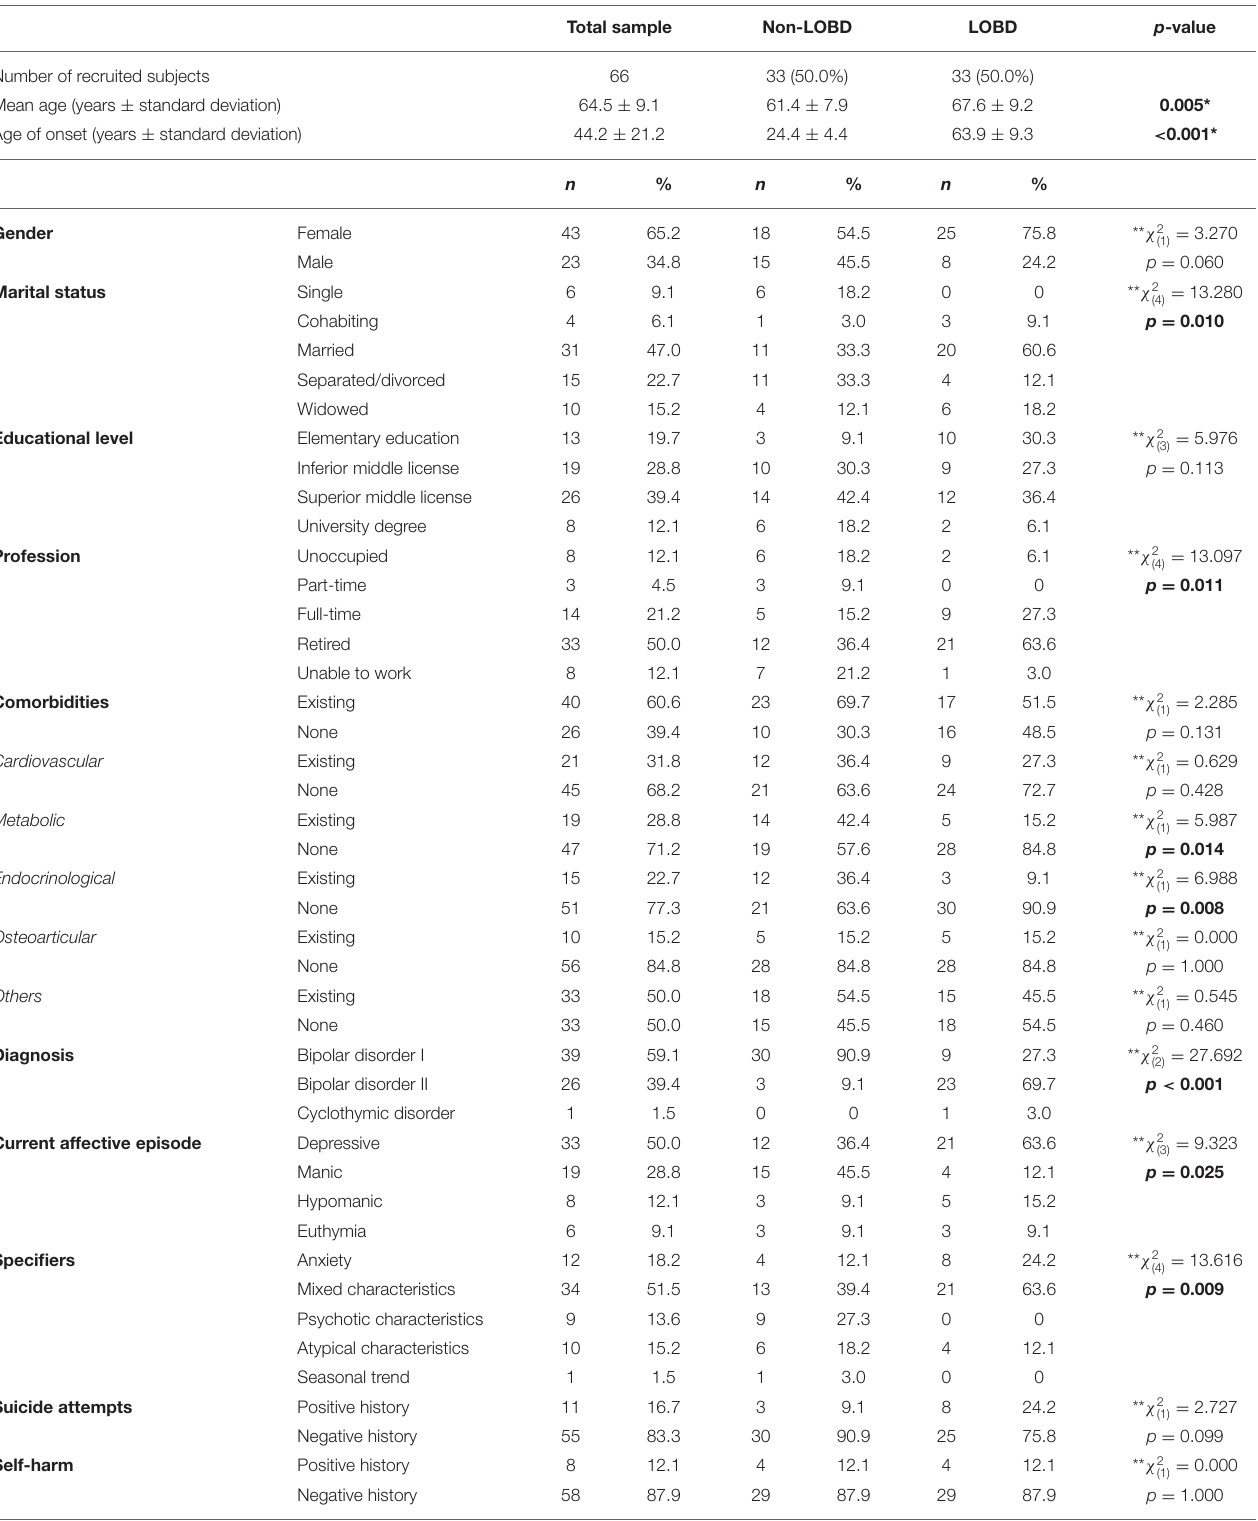
Total sample Non-LOBD LOBD p -value